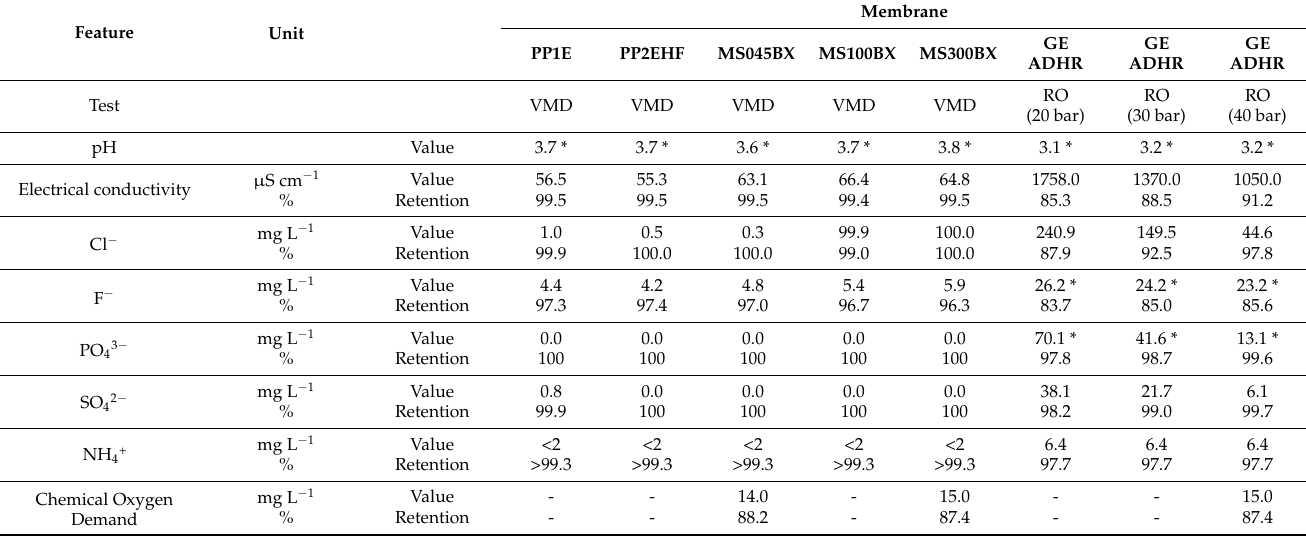
Table 4. Physical-chemical characterization of average MD distillate and RO permeate samples (* indicates values out of the